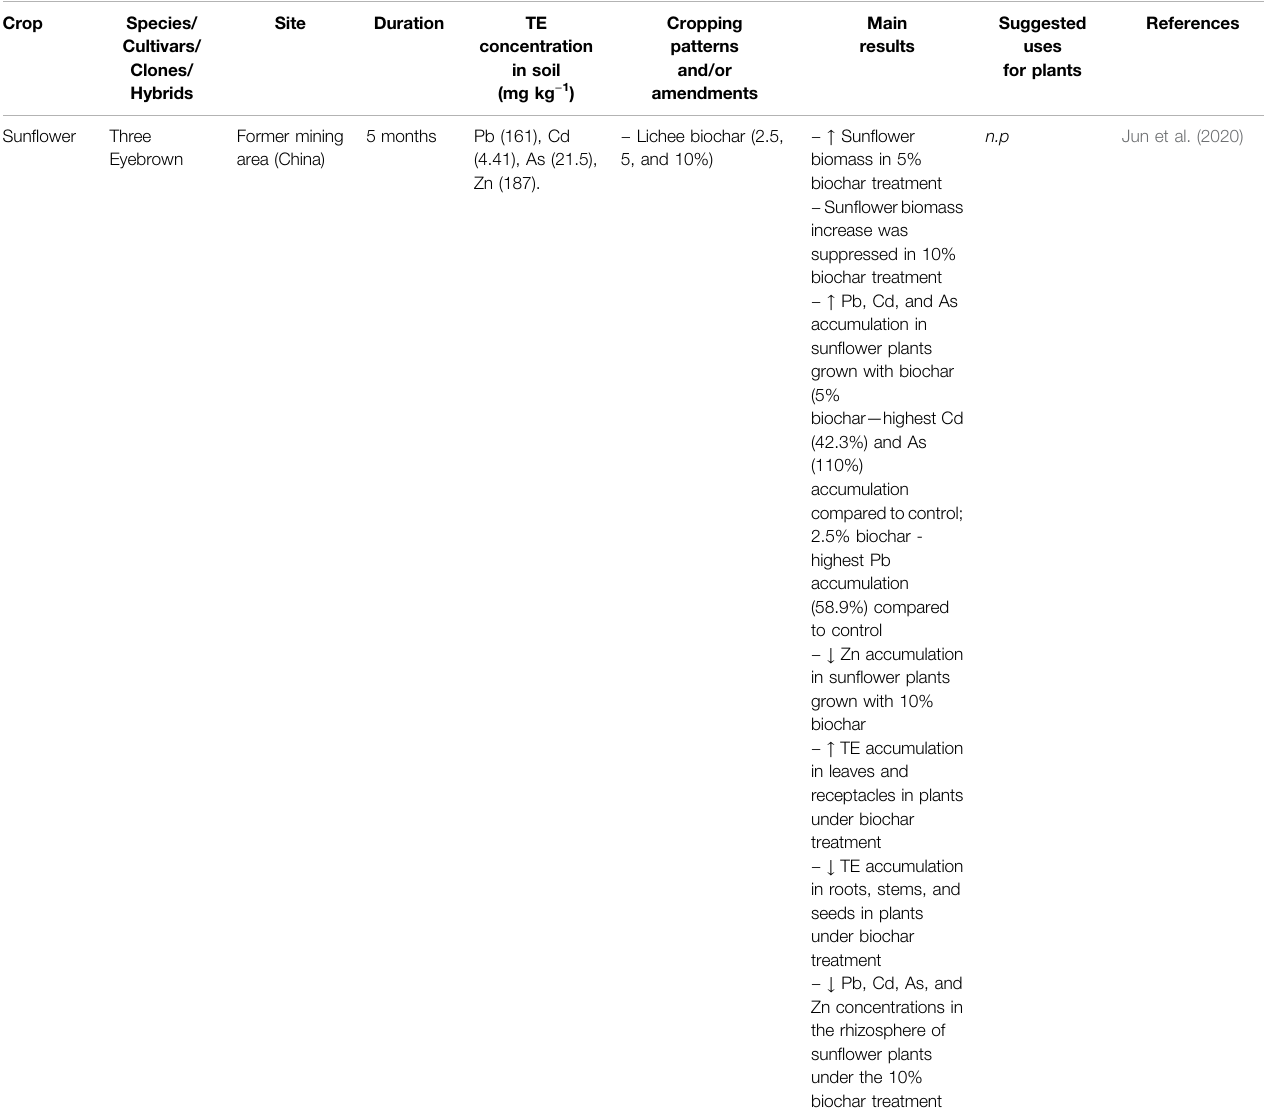
TABLE 4 | ( Continued ) Examples of fi eld trials with economically valuable crops under different cropping patterns and/or amendments